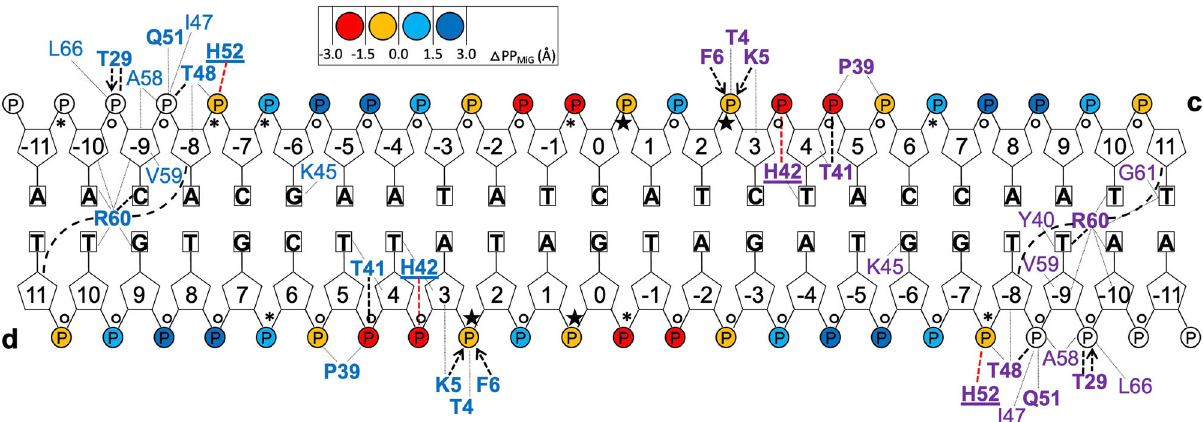
Fig. 2 Cartoon of the Sc NsrR- hmpA1 complex. Blue- and purple-labeled residues belong to different NsrR subunits. Nucleotides are numbered from 0 at the center of the fi gure. Contacts with distances (d) < 3.3 Å from hmpA1 strands c and d to NsrR residues depicted in bold are shown by black dashed lines for H-bonds, by dashed arrows if a main chain N atom is involved and by red dashed lines for possible salt bridges with His42 and His52. Thin lines depict remaining contacts with d < 3.8 Å, including those for disordered NsrR residues (see also Table S1). Circles depicting phosphate (P) groups are colored according to the corresponding minimal P-to-P distance across the MiG relative to its average value of 11.7 Å in regular B-DNA ( Δ PP MiG ). Small circles and black stars indicate phosphate torsion angles in the B I and B II backbone conformation, respectively; asterisks highlight those with an intermediate conformation.